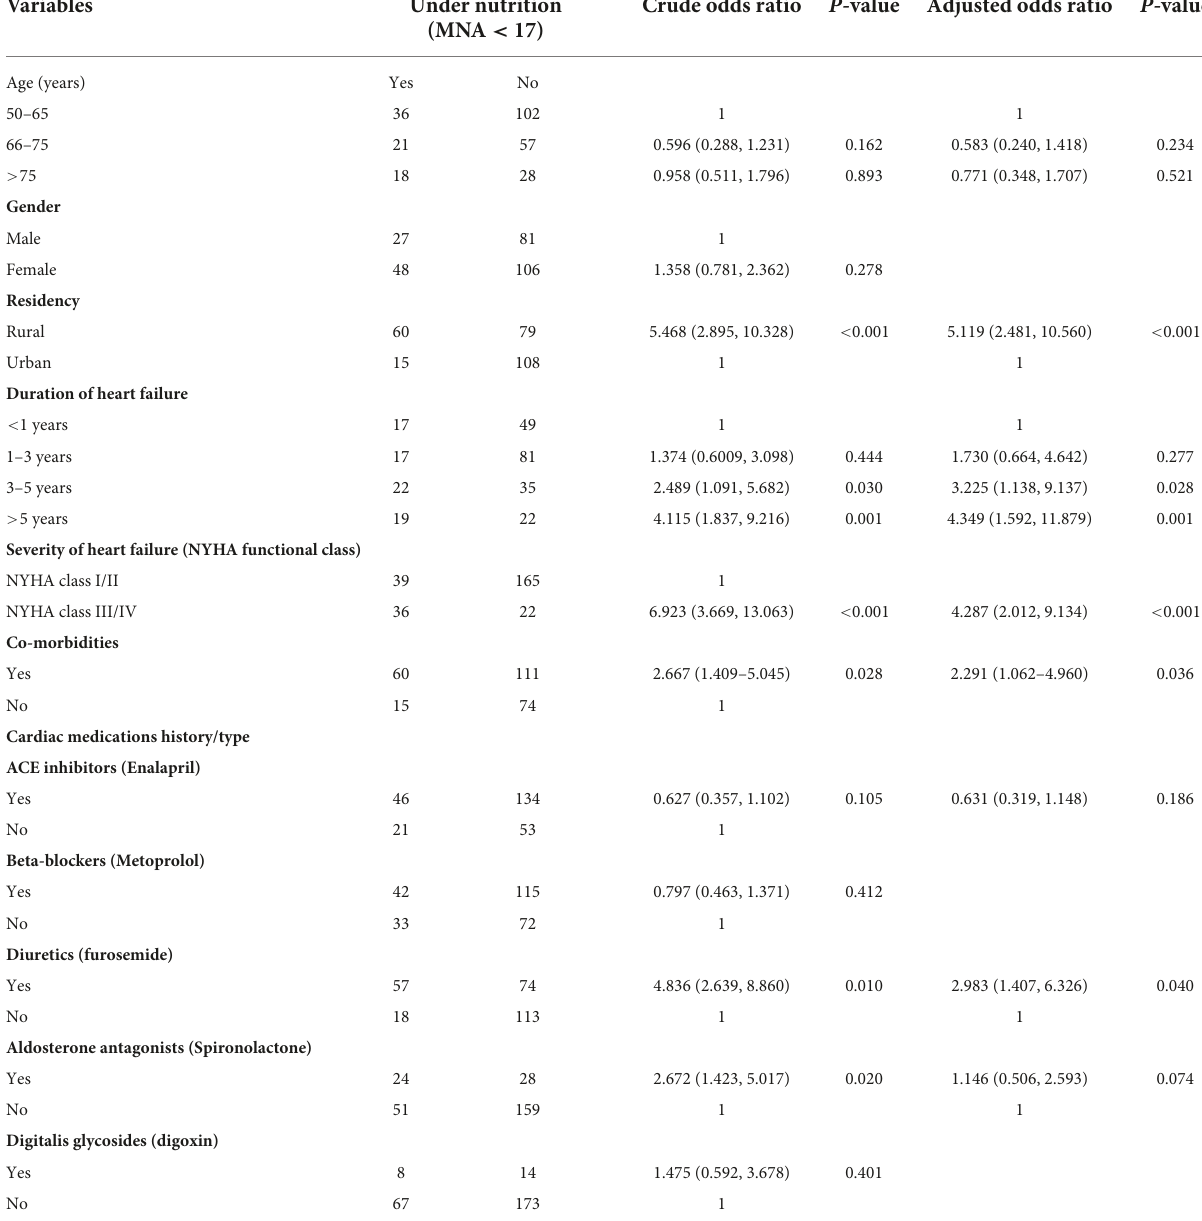
TABLE 9 Bivariate and multivariate analysis of older adult patients with heart failure at Cardiac Clinic, University of Gondar hospital, June 01, 2021 to October 31, 2021 (No. 262). Variables Under nutrition Crude odds ratio P -value Adjusted odds (MNA < 17)